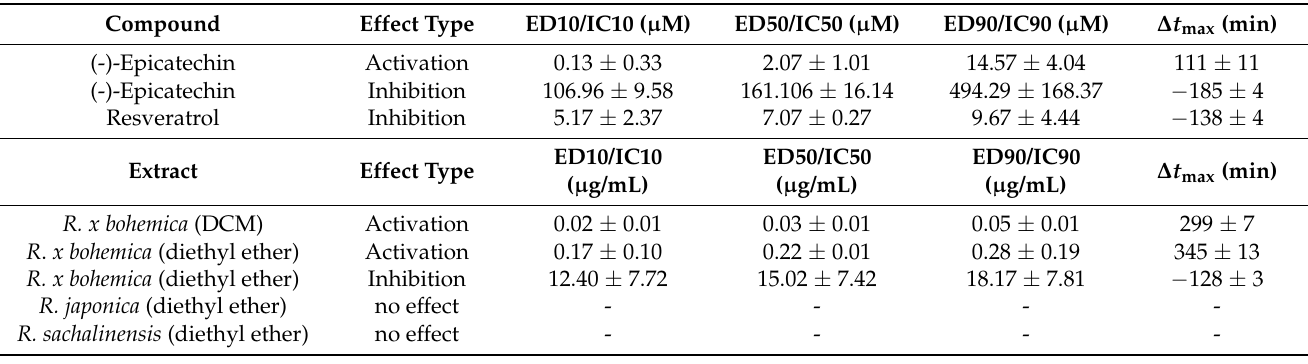
Table 4. ED 10/50/90 values determined for compounds and extracts activating the antimicrobial properties of the LPO system and IC 10/50/90 in the case of compounds/extracts inhibiting the antimicrobial activity. The ∆ t max parameter determines the maximum recorded effect strength.